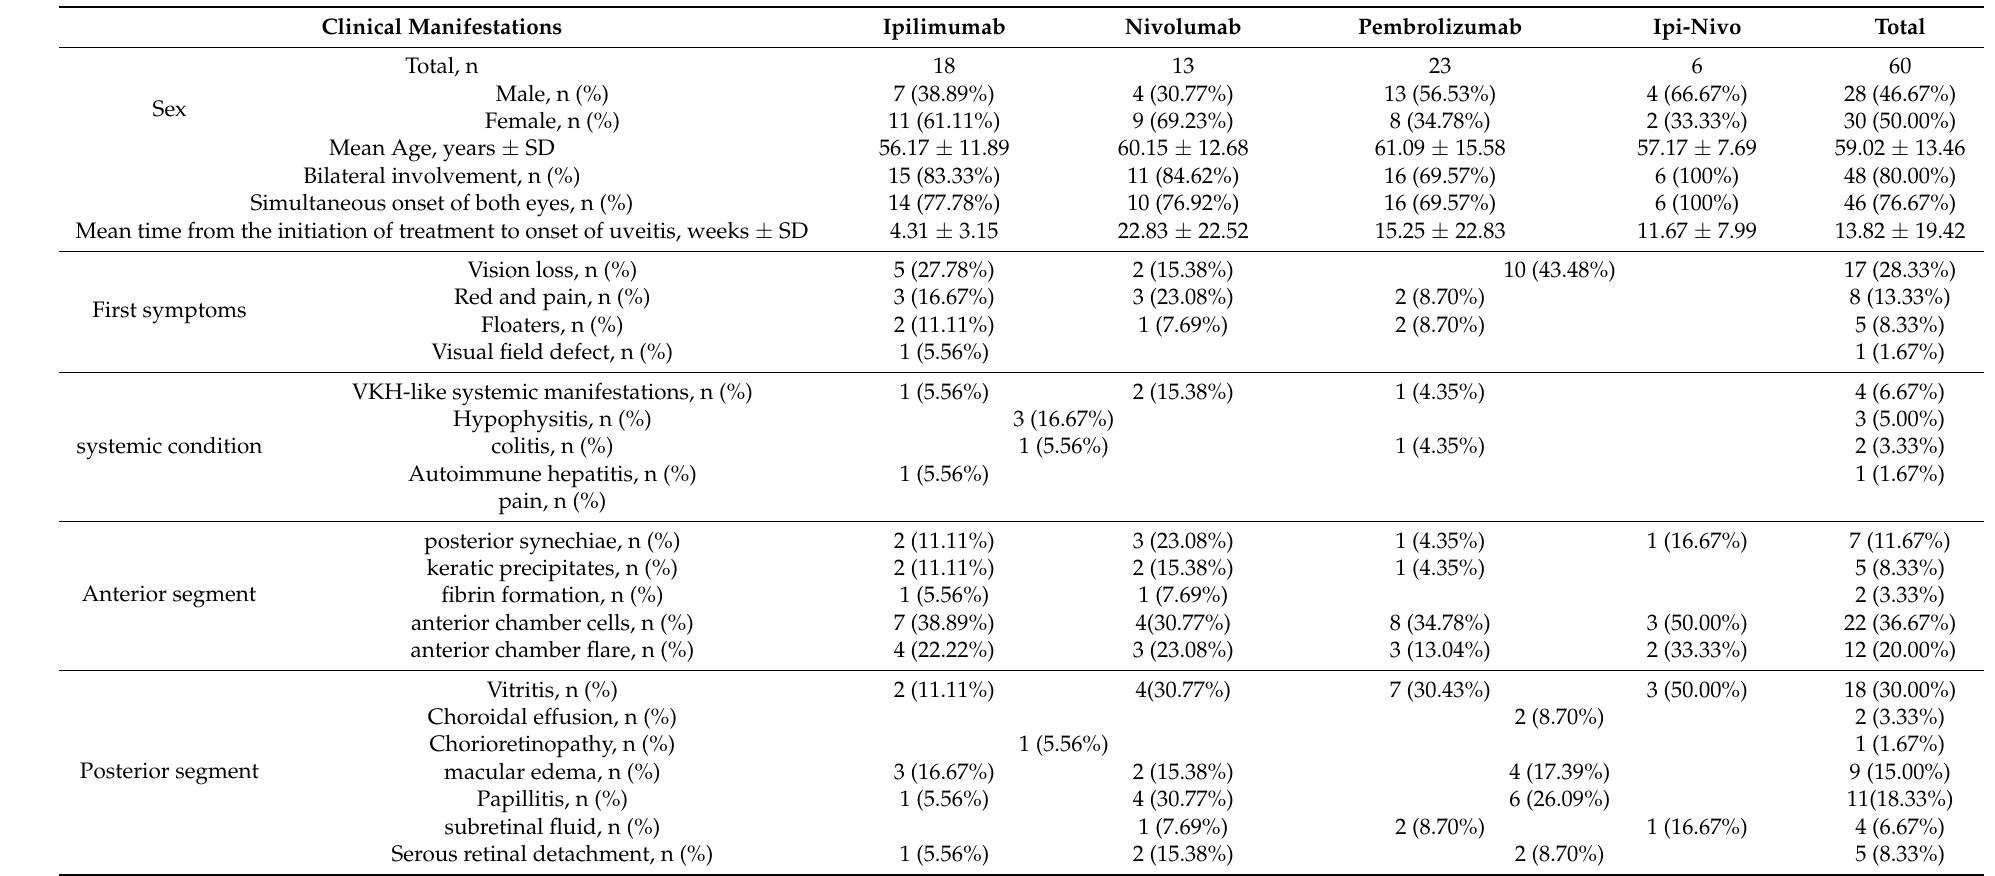
Table 2. Clinical manifestations of uveitis caused by